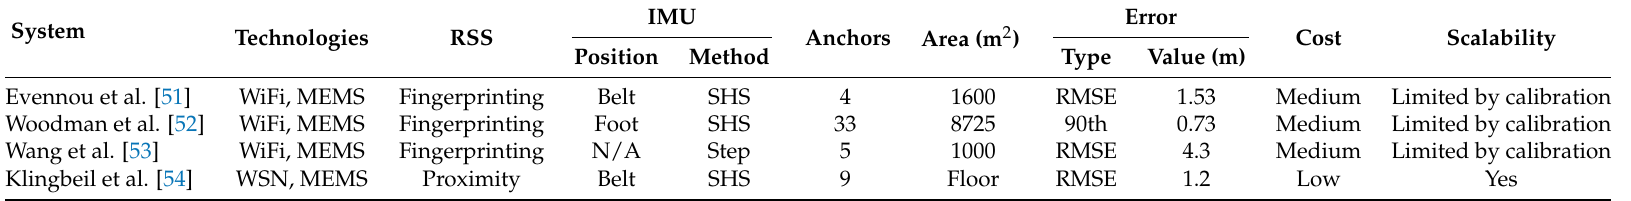
Table 4. Map hybrid positioning